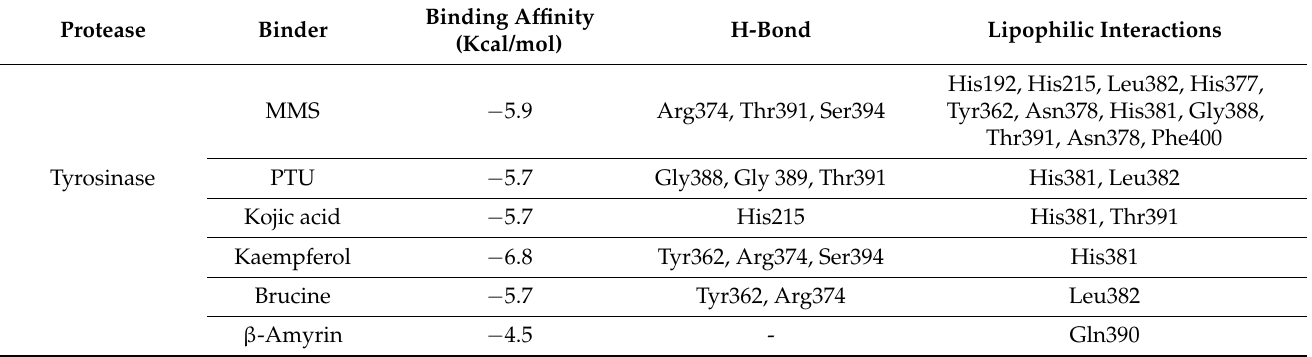
Table 2. Results of binding a ffi nities and their main interactions at the human tyrosinase receptor.